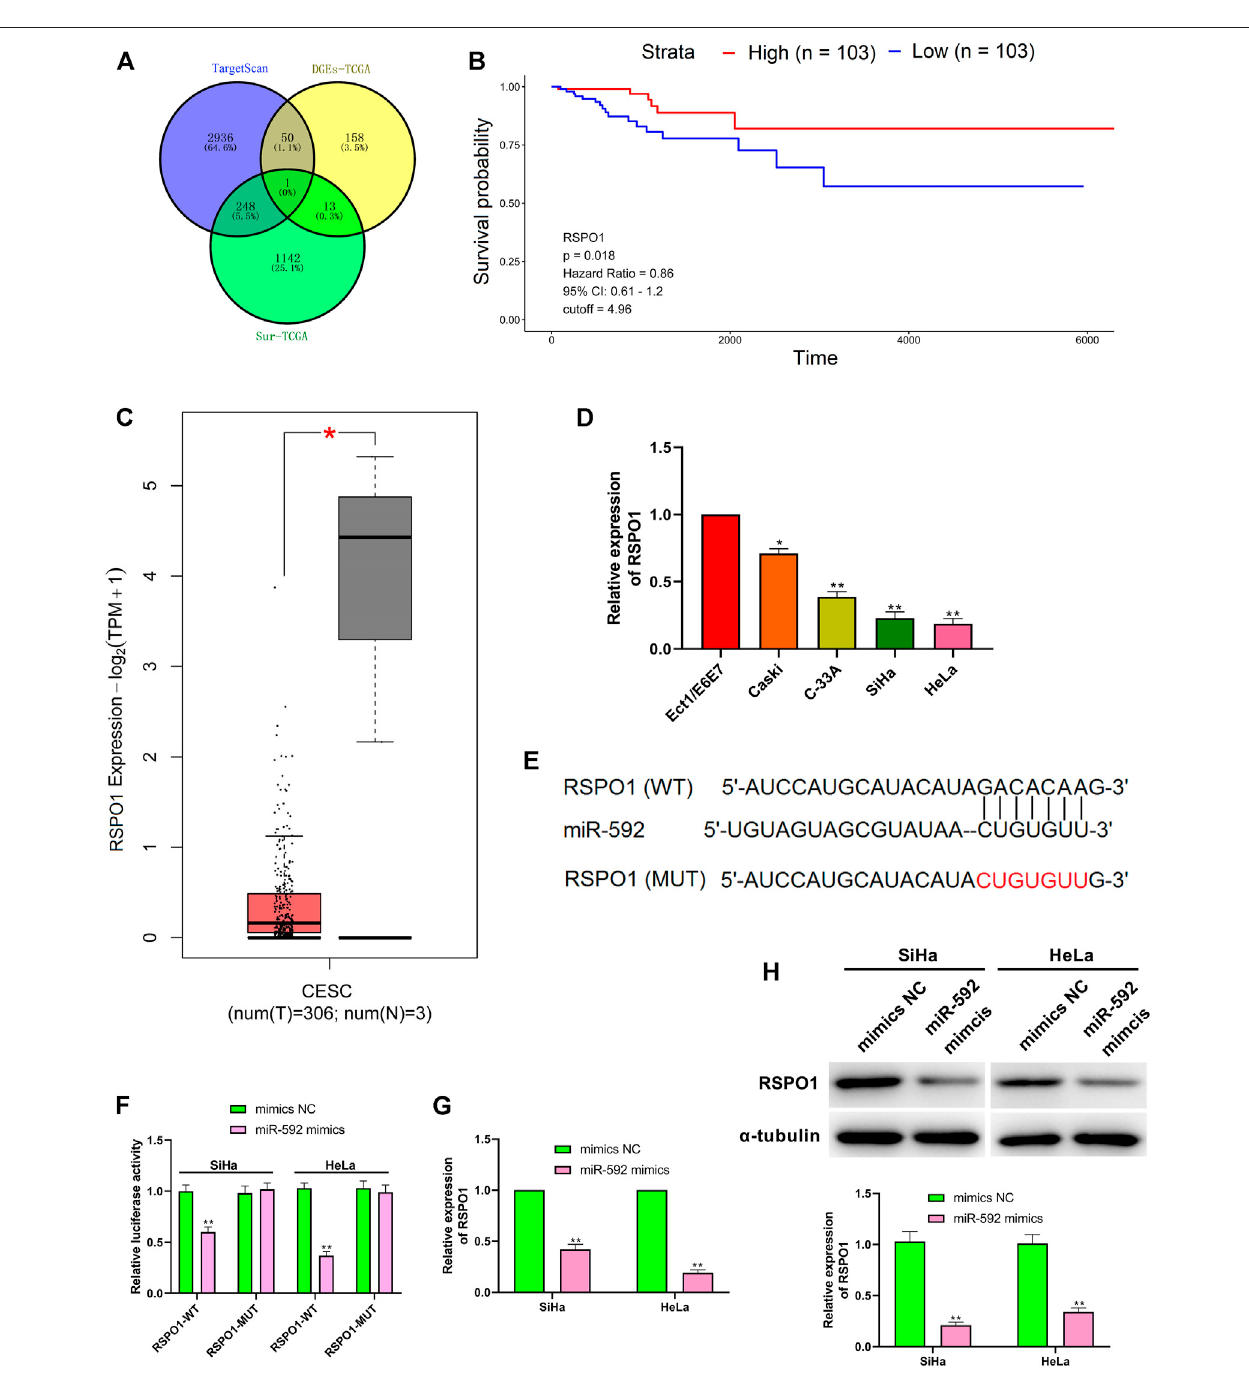
FIGURE 5 | RSPO1 was the target of miR-592. (A) TargetScan, the differentially expressed mRNA screened from TCGA database and the mRNA with signi fi cant survival differences screened from TCGA database are used to predict RSPO1 can bind to miR-592; (B) Kaplan-Meier survival curve from TCGA described the overall survival (the criteria of twogroups was Quartile); (C) The expression of RSPO1 in CC tissues compared with the normal tissues in the GEPIA website; (D) qRT-PCR was performed to detect the RSPO1 expression in cervical cancer cell lines (Caski, C-33A, SiHa, and HeLa) and normal cervical cell (Ect1/E6E7); (E) TargetScan predicts the binding sites between miR-592 and RSPO1; (F) luciferase activity of RSPO1-wt, RSPO1-mut upon the transfection of miR-592 mimics or mimics NC was evaluated by luciferase reporter assay; (G) The mRNA expression of RSPO1 was detected in SiHa and HeLa cells by qRT-PCR after transfection with miR-592 mimics; (H) The protein expression of RSPO1 was detected in SiHa and HeLa cells by qRT-PCR after transfection with miR-592 mimics. Measurement data were expressed as mean ± standarddeviation.Thecellexperimentisrepeatedthreetimesindependently.* p < 0.05,comparedwithnormaltissues (C) ;* p < 0.05,** p < 0.01,comparedwith Ect1/E6E7 group (D) ; ** p < 0.01, compared with mimics NC group (F – H) .